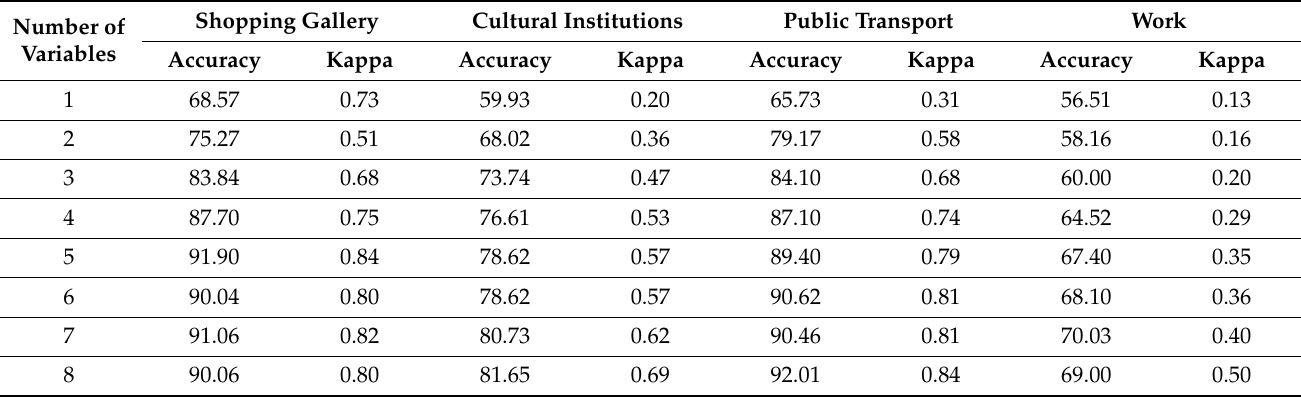
Table 2. Recursive feature elimination for four distinct predictive models.